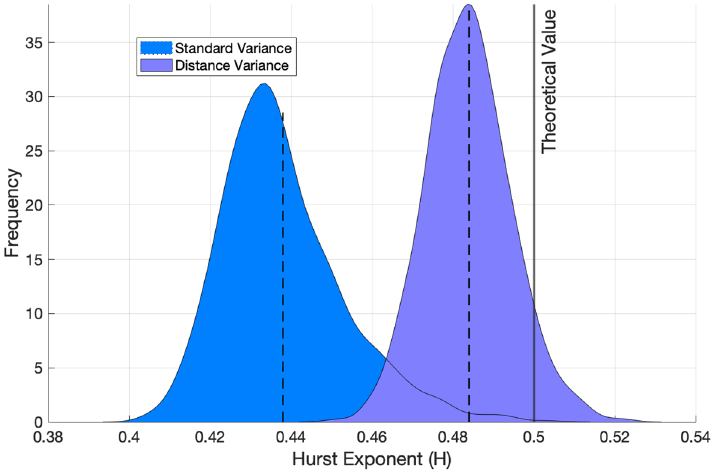
Figure 2. Hurst exponent estimated from the standard and the distance variance-based